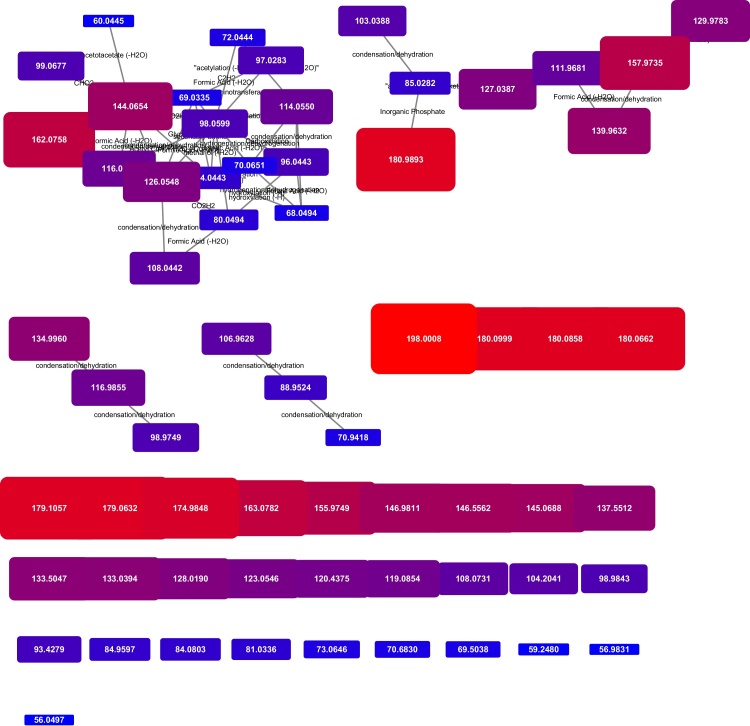
Transformation network from a single selected MSMS spectrum – fragmentation of a 180.09 peak. While several orphan fragments are present, a large cluster of clearly chemically related peaks, linked to the base peak in the spectrum are visible along with four additional peak group clusters.